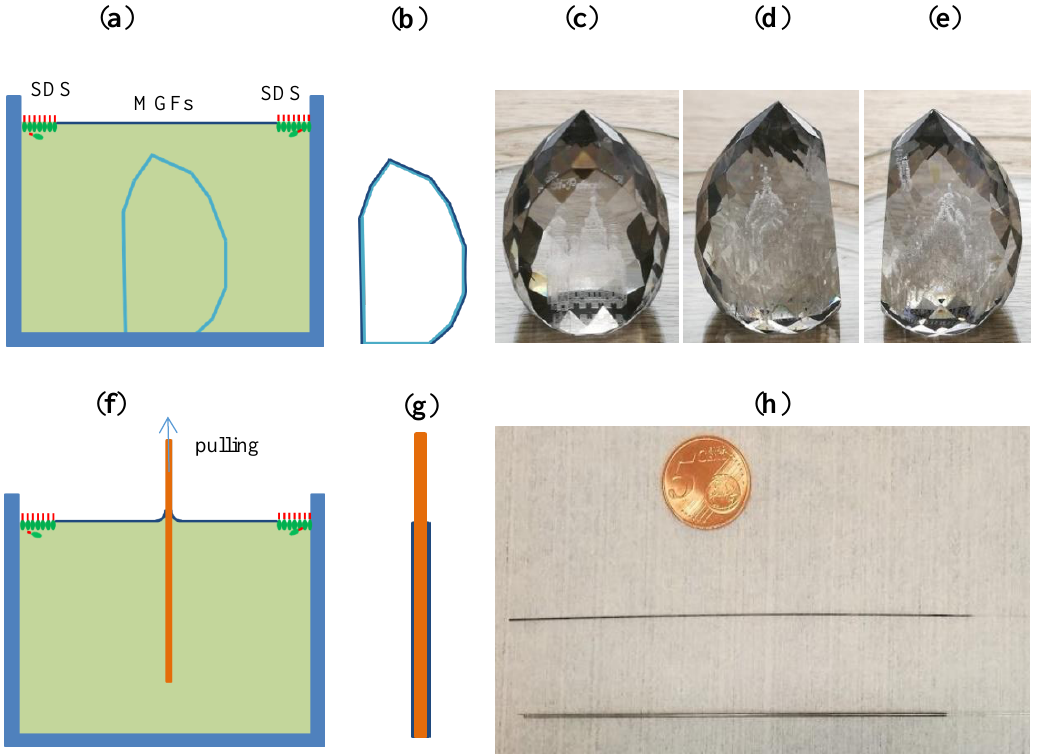
Figure 5. ( a ) The glass souvenir was placed beneath the MGFs. ( b ) A schematic view of the MGFs attached on the surface of the 3D object, and a conformal and homogenous coating was realized on the facets by pumping out of the water. Photographs of the glass souvenir coated with MGFs from ( c ) front, ( d ) right side and ( e ) left side. ( f ) The procedure for the MGFs coating on glass fibers. ( g ) A conformal coating of MGFs was realized on the glass fiber by pulling it out of water. ( h ) Glass fibers coated with three stacks of MGFs by repeating the process; the diameter of the upper glass fiber was 0.42 mm, and the length of the coated piece was 11 cm. The diameter of the lower glass fiber was 0.93 mm, and the length of the coated piece was 10 cm.